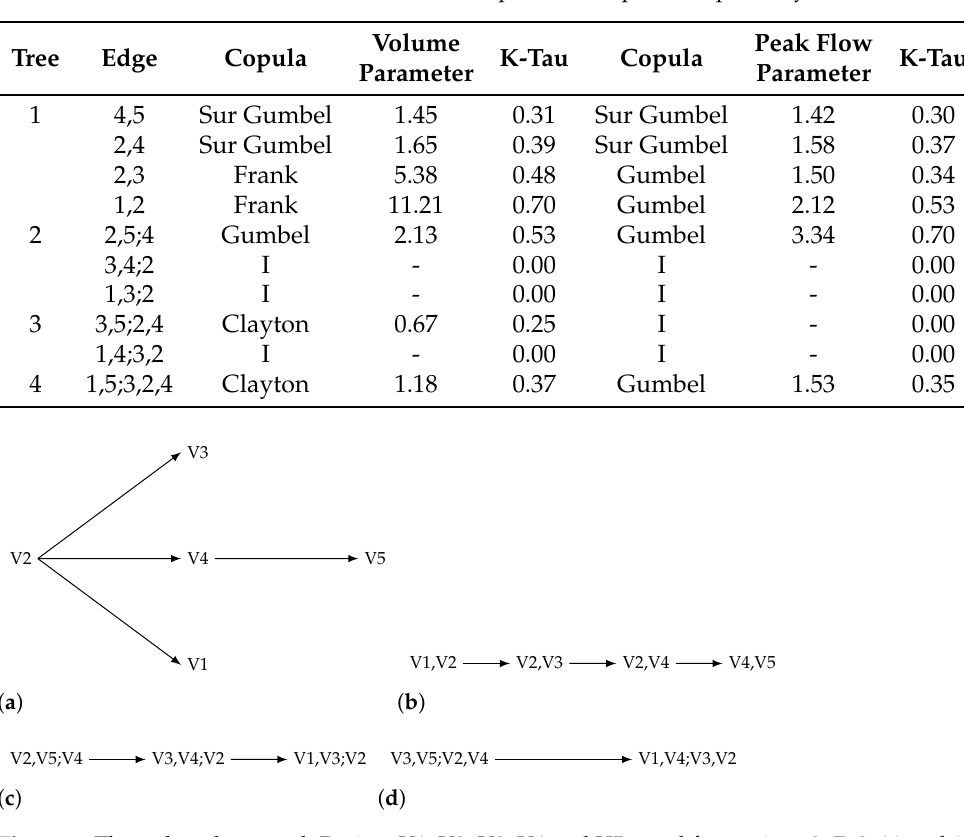
Table 3. Bivariate copulas and conditional bivariate copulas of the reduced-network R-vine. Sur Gumbel and I stand for Survival Gumbel and Independence copulas, respectively.